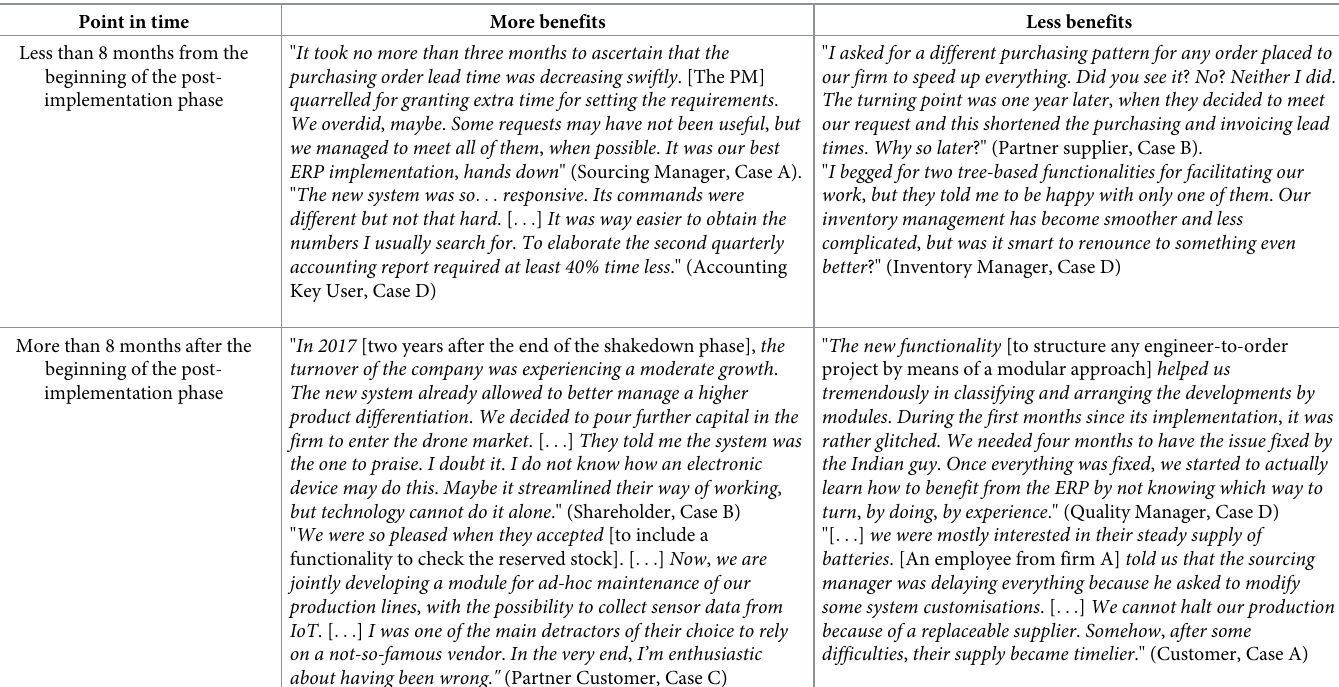
Table 5. Examples of case quotations on the requirements-benefits causal relationship over time. Point in